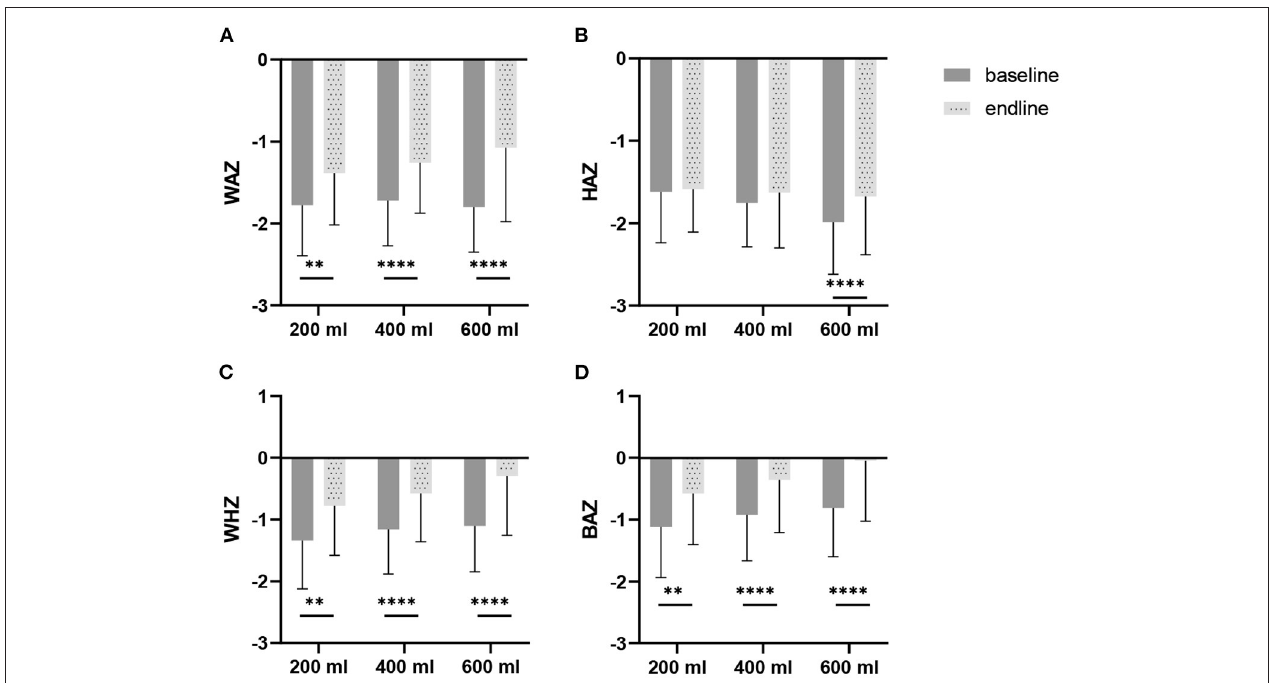
FIGURE 3 | Weight-for-age z-scores (WAZ), height-for-age z-scores (HAZ), weight-for-height z-scores (WHZ), and BMI-for-age z-scores BAZ), at baseline and after 6 months of intervention, in Nigerian toddlers with malnutrition, provided with a fortified dairy-based drink in daily amounts of 200, 400 or 600 ml: (A) WAZ, (B) HAZ, (C) WHZ, and (D) BAZ. The difference between baseline and endline was tested with a paired t -test per study group. * p < 0.05, ** p < 0.01, *** p < 0.001, **** p <